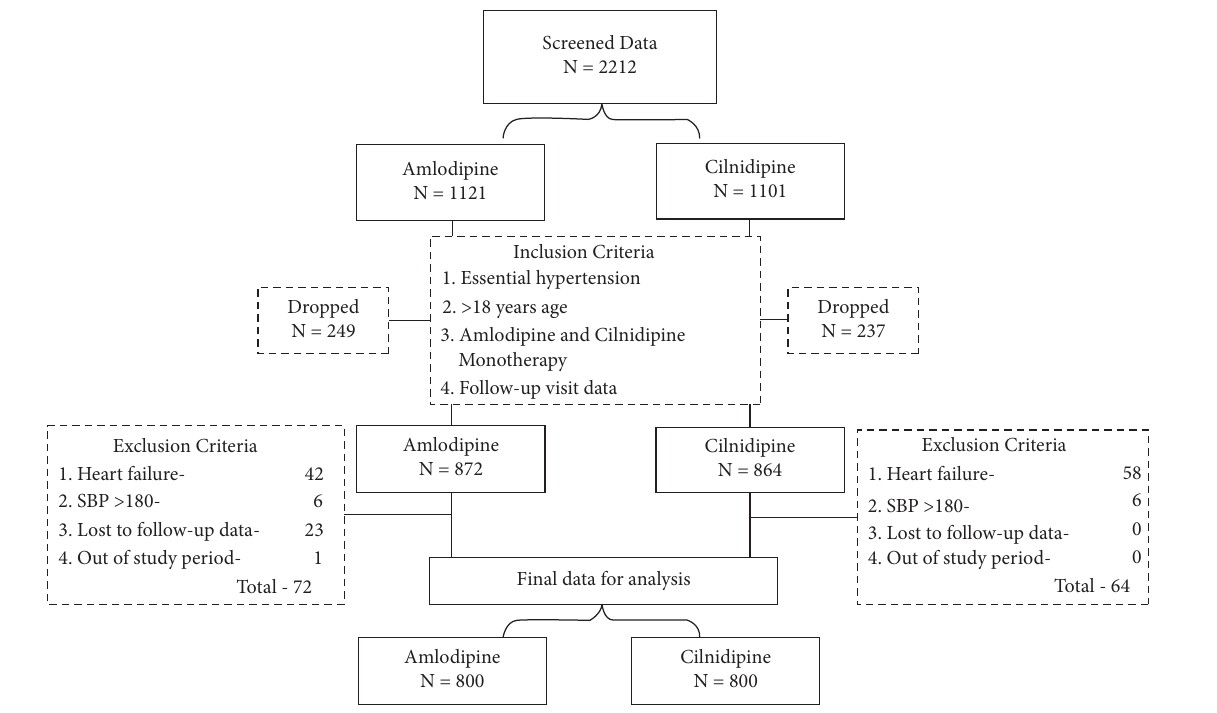
Figure 1: Study sample selection